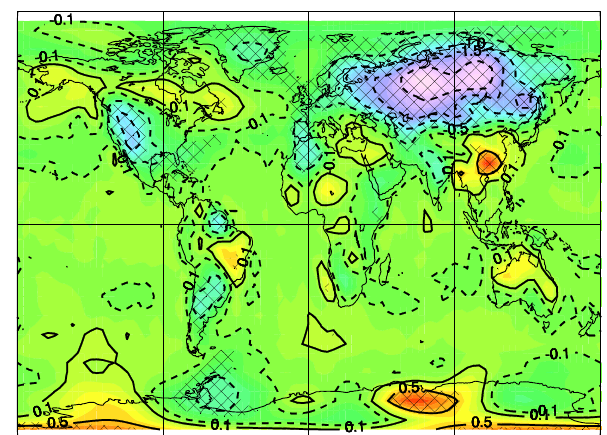
Fig. 7. The geographical distribution of the annual mean total ozone loss (%) calculated as the relative deviation of noMPA from MPA results for the year 2030.